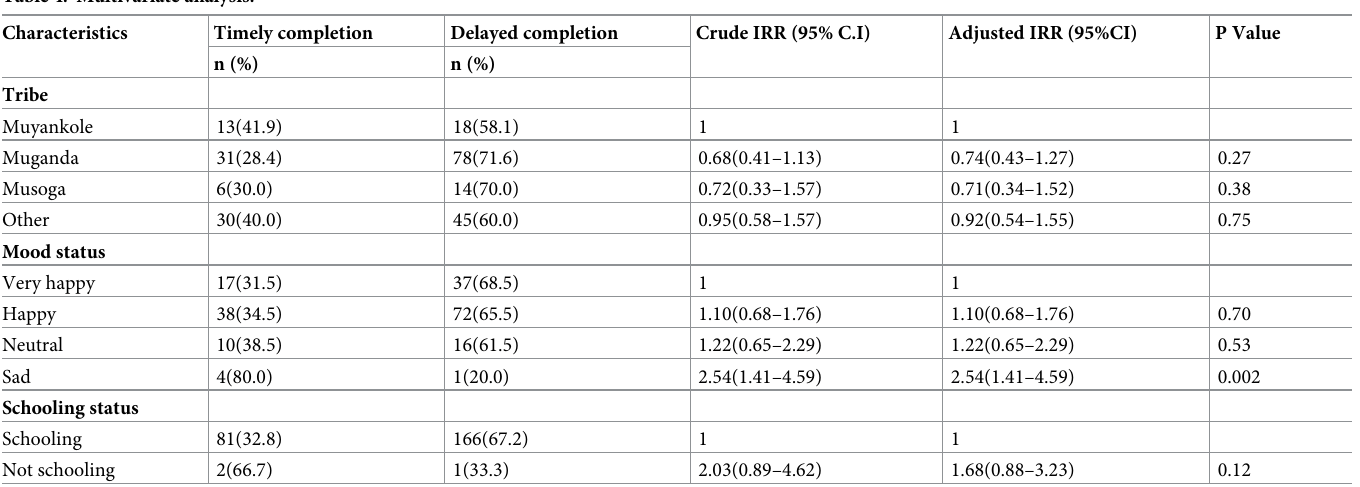
Table 4. Multivariate analysis.